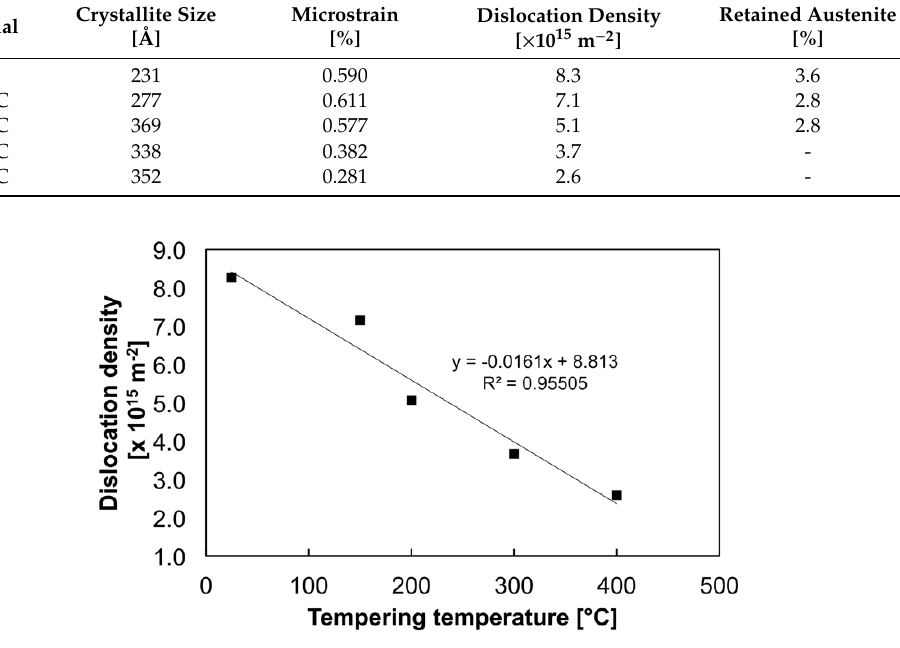
Figure 10. Dislocation densities of the tested steels (WQ tempering temperature set as 25 °C).